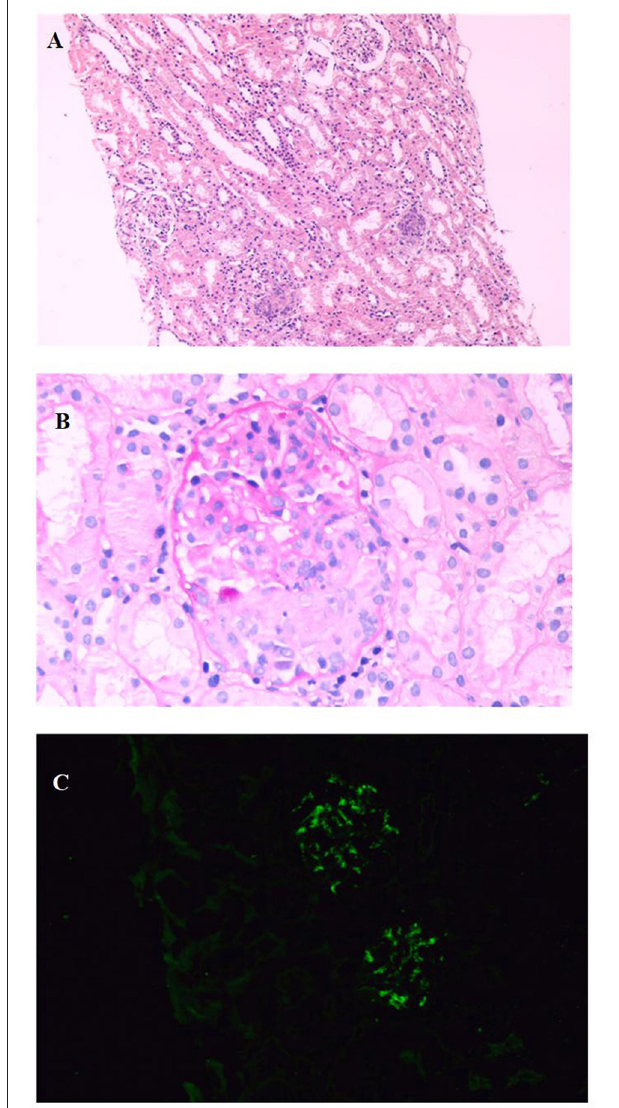
FIGURE 2 | Renal biopsy shows: (A). The number of cells in the glomerulus increased, focal and segmental hyperplasia of mesangial cells and stroma, and multiple crescents (HE, X100); (B) . Cellular crescents (PAS, X400); (C) . IgA deposited in glomerular mesangial area (IF,